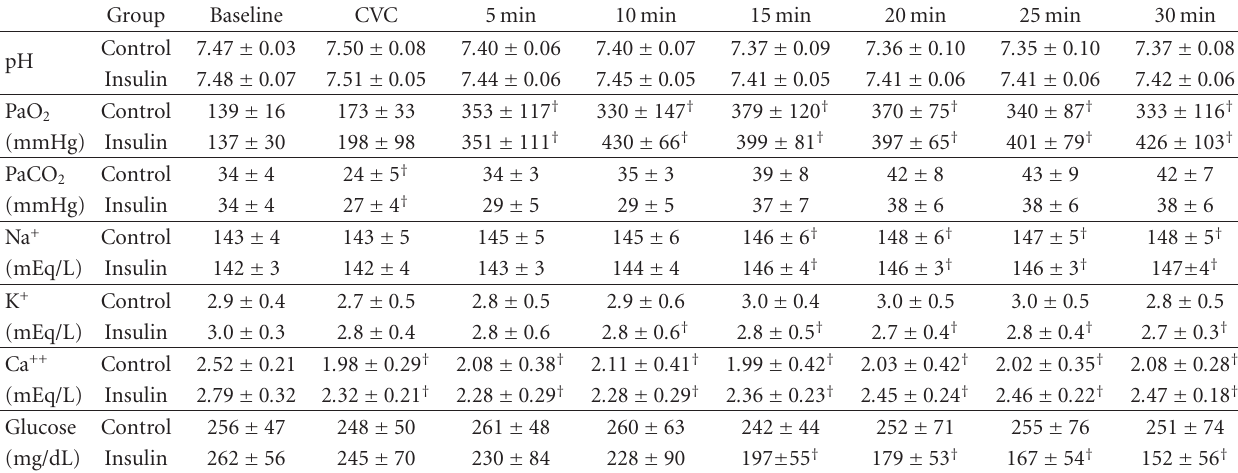
Table 2: Changes of arterial blood gas, serum electrolyte, and blood glucose concentration in the control and insulin groups. Group Baseline CVC